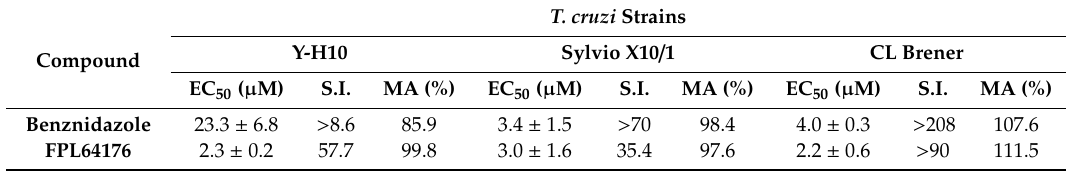
Table 2. FPL64176 against Y-H10, Sylvio X10 / 1 and CL Brener T. cruzi strains infecting U2OS host cells.